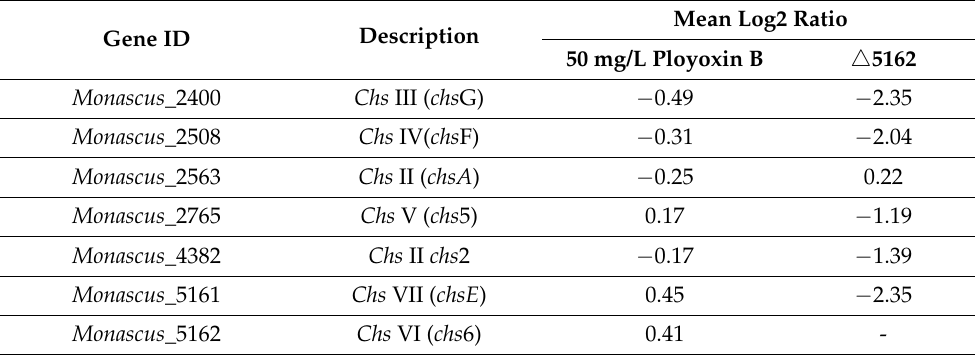
Table 3. Comparison of the gene expression levels of different members of chitin synthesis at 3 days during submerged fermentation by addition of 50 mg/L of ployoxin B and deletion of chs 6 gene in M. purpureus